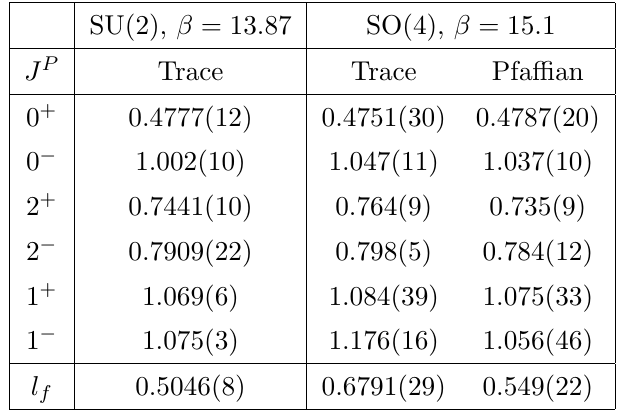
Table 3 . Lightest glueball masses SU(2) and SO(4) on a 34 2 56 lattice at the couplings shown for various spins J and parity P . Also shown is the energy of the lightest (cid:13)ux tube, l f , winding around a periodic spatial